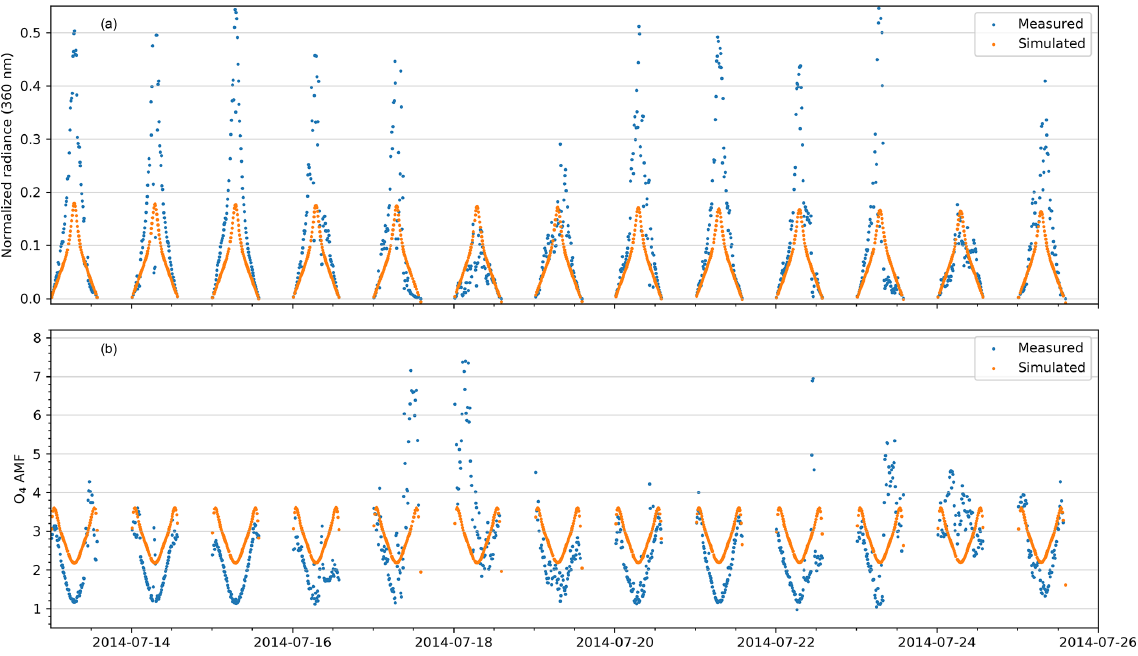
Figure B3. (a) Measured calibrated radiances in the zenith direction and (b) O 4 AMFs derived for zenith direction for a selected short period of the measurements, over which the instrument properties were almost constant. Also shown are the simulation results for the SZA- dependent thresholds. On some days greatly enhanced O 4 AMFs are found, indicating the presence of optically thick clouds. On these days, greatly decreased radiances are also